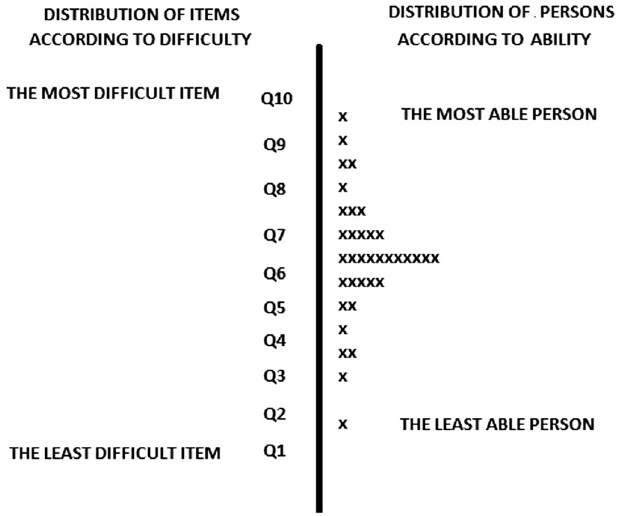
FIG. 1. An example of the Wright map (item-person map), representing a hypothetical distribution of items (Q1 – Q10) and persons (each person is represented by “ x ” ) along the same variable. The variable is represented by a straight line in the middle and increases in upward proposed latent trait models, the Rasch model has fewest parameters: one ability parameter for each person, and one difficulty parameter for each item [38]. The Rasch model is